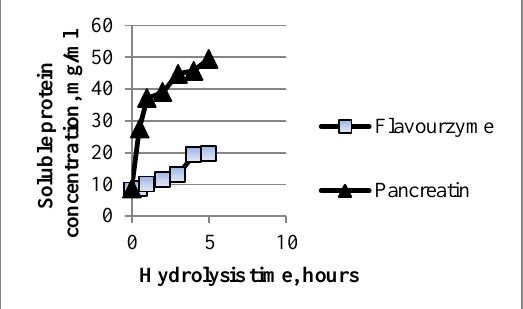
Fig. 2. The soluble protein content of Yeast extract during autolysis